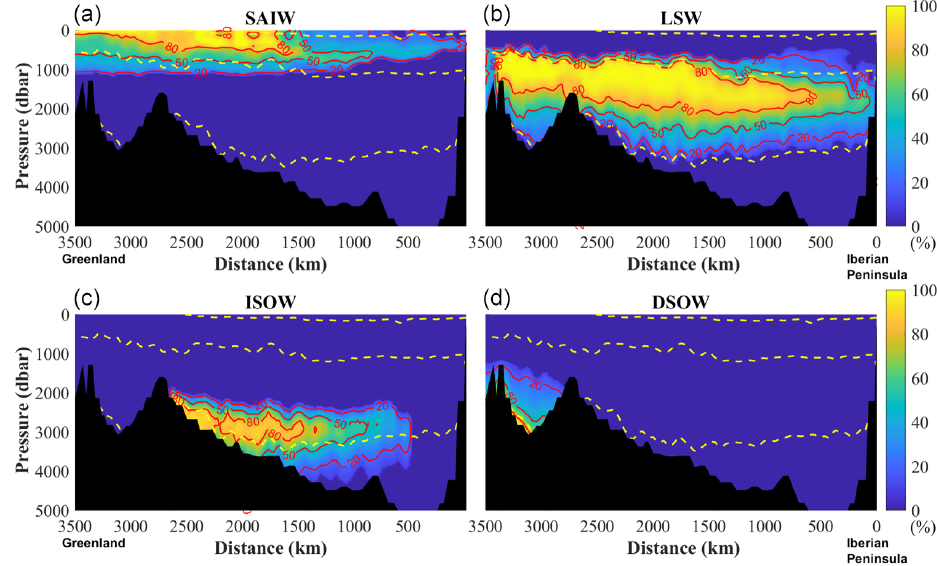
Figure 13. Distribution of SAIW (a) , LSW (b) , ISOW (c) and DSOW (d) based on the A25 section. Contour lines show fractions of 20%, 50% and 80%, and dashed yellow lines show the vertical boundaries of layers (neutral density at 27.10, 27.90 and 28.10kgm − 3